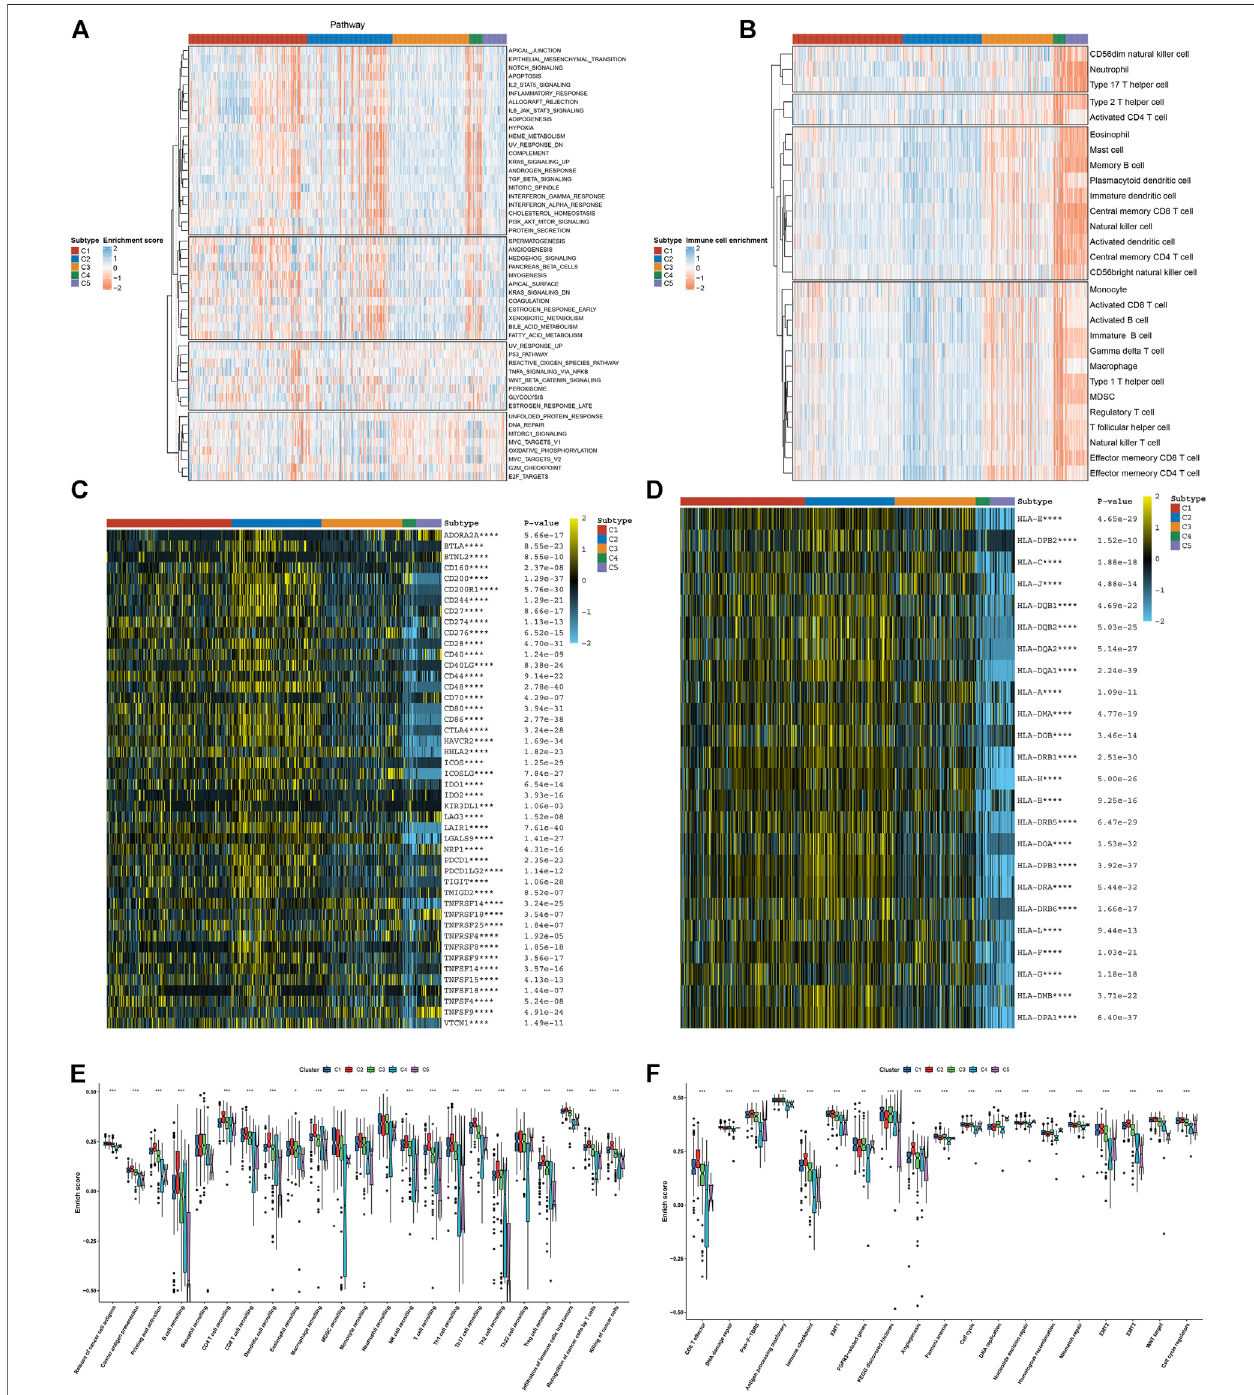
FIGURE 2 | Five necroptosis subtypes with diverse immunogenic features. (A) Quanti fi cation of the activation levels of known hallmarks of cancer pathways in fi ve necroptosis subtypes. (B) Estimation of the in fi ltration levels of immune cell populations in diverse necroptosis subtypes. (C,D) Visualization of the mRNA expression of (C) immune checkpoints and (D) HLA molecules across necroptosis subtypes. (E) Comparison of the enrichment scores of all steps within the cancer – immunity cycle among fi venecroptosissubtypes. (F) Comparisonoftheenrichmentscoresofknownbiologicalprocessesin fi venecroptosissubtypes.* p < 0.05;** p < 0.01;*** p < 0.001; and **** p <